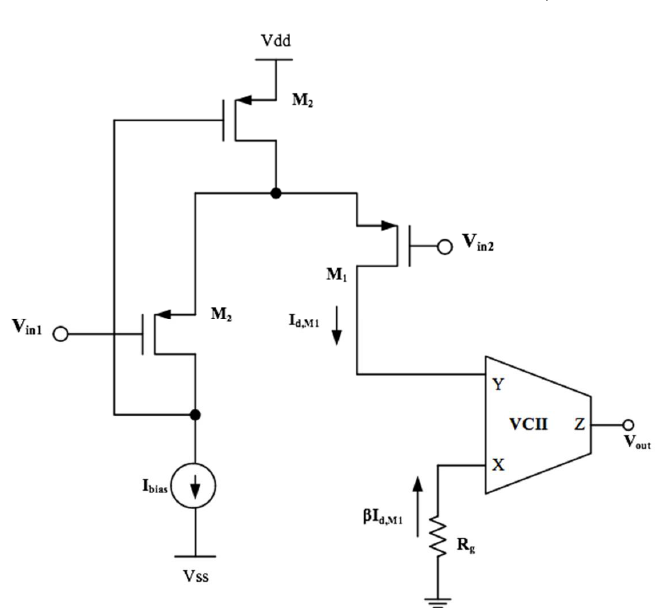
Figure 12. VCII-based readout circuit for bioelectrical sensing